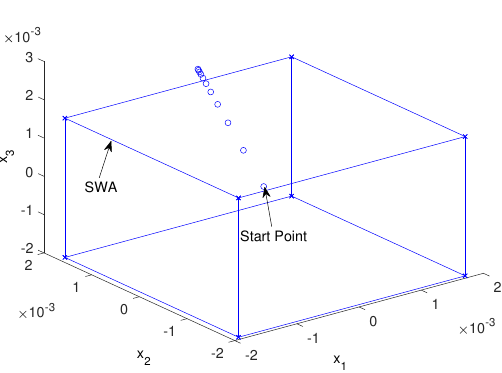
Figure 10. A pH system simulation with input signal outside predefined set